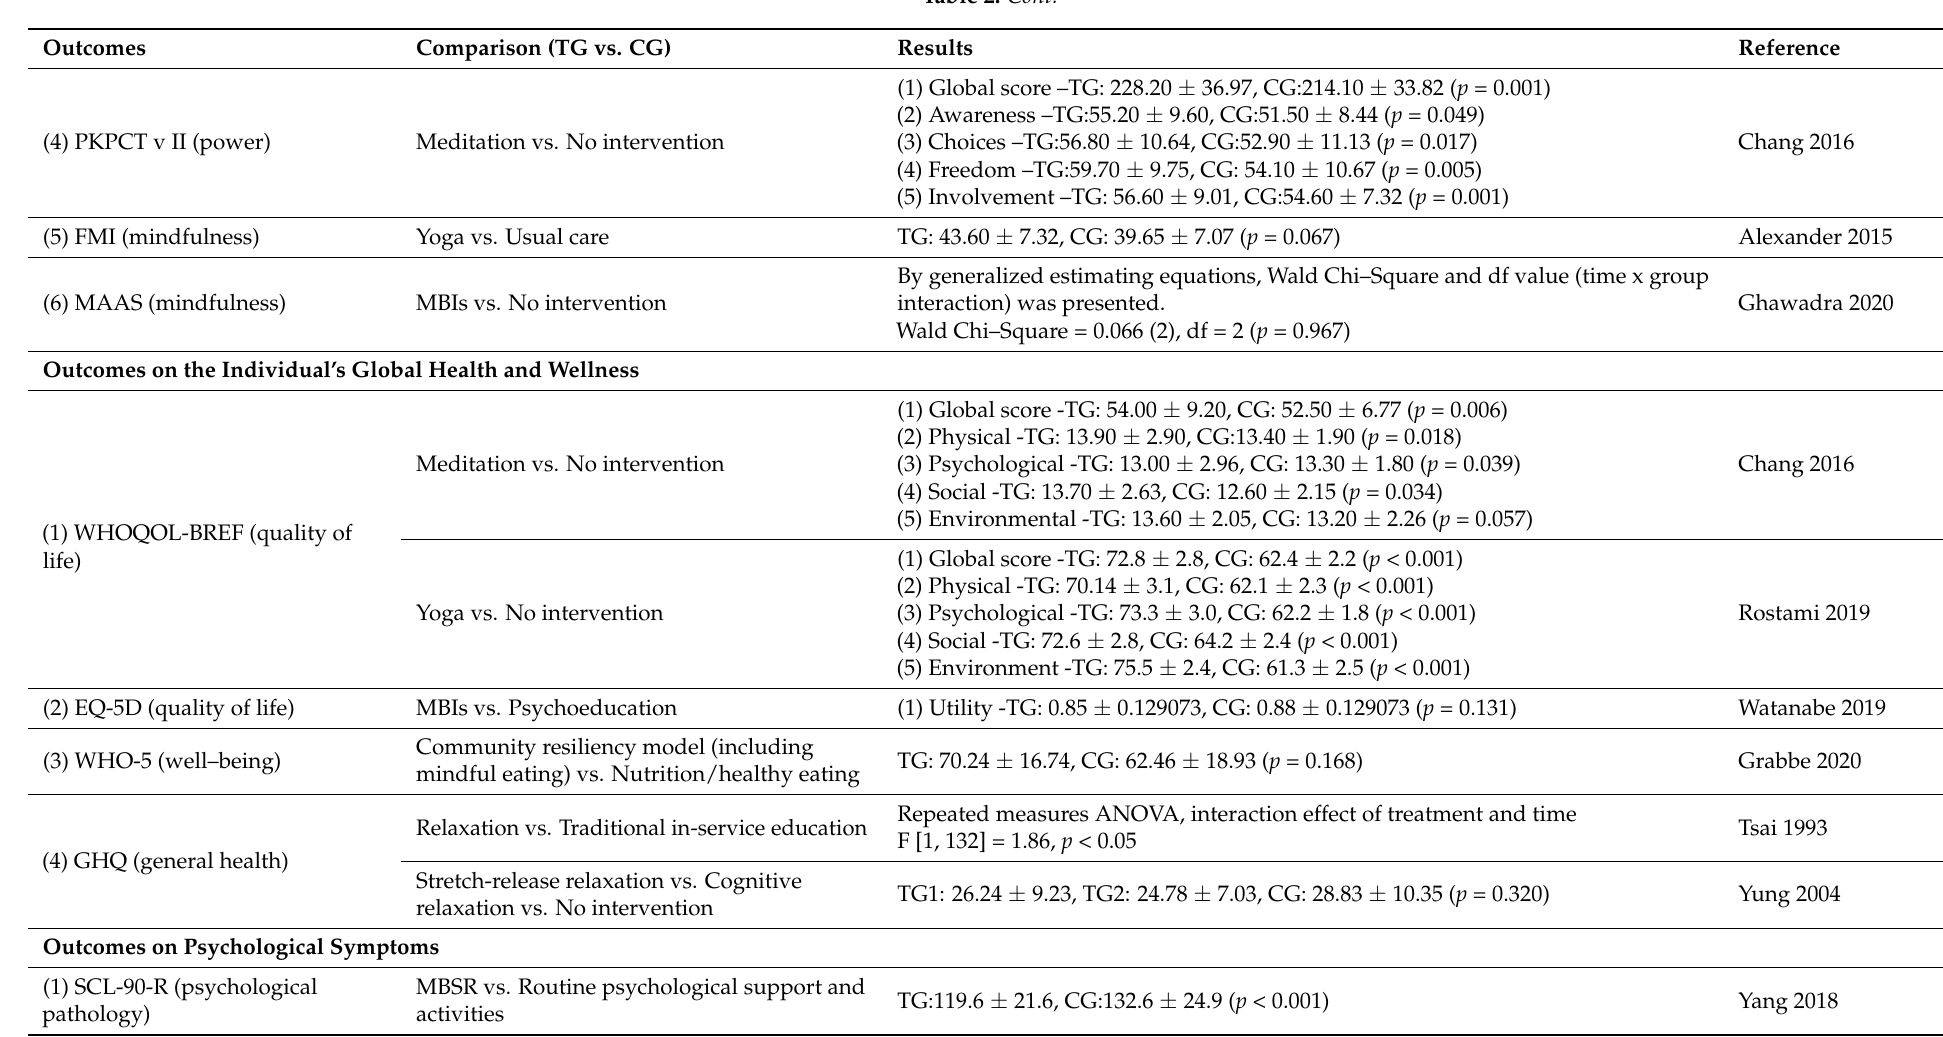
Outcomes Comparison (TG vs. CG) Results Reference